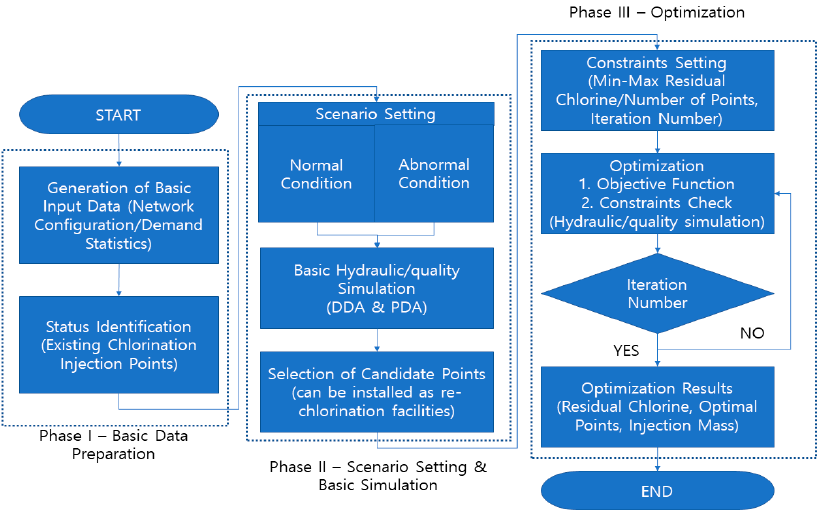
Figure 1. Proposed model operation procedure.